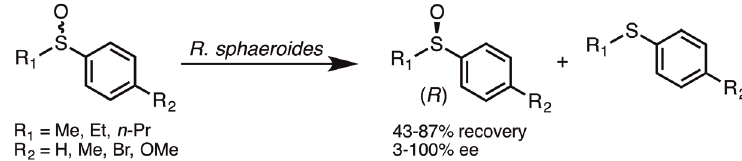
Figure 18 - Deoxygenation of racemic sulfoxide by Rhodobacter sphaeroides f . sp. denitrificans (Abo et al. 1997).